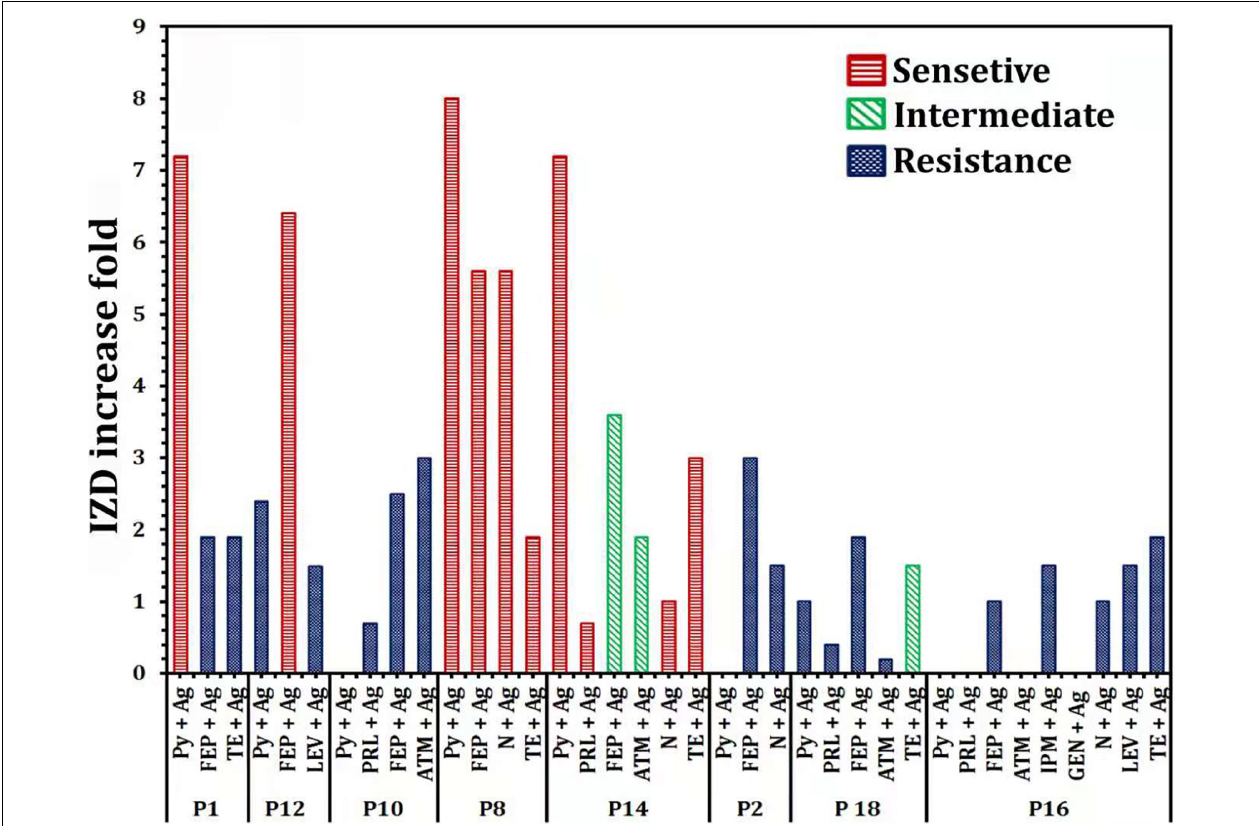
FIGURE 5 | Increase fold of antibacterial activity of antibiotics alone or in combination with Ag-NPs against selected P. aeruginosa isolates. IPM, imipenem; GEN, gentamicin; LEV, levofloxacin; PRL, piperacillin; N, neomycin; TE, tetracycline; ATM, aztreonam; FEP, cefepime; Py, carbenicillin.